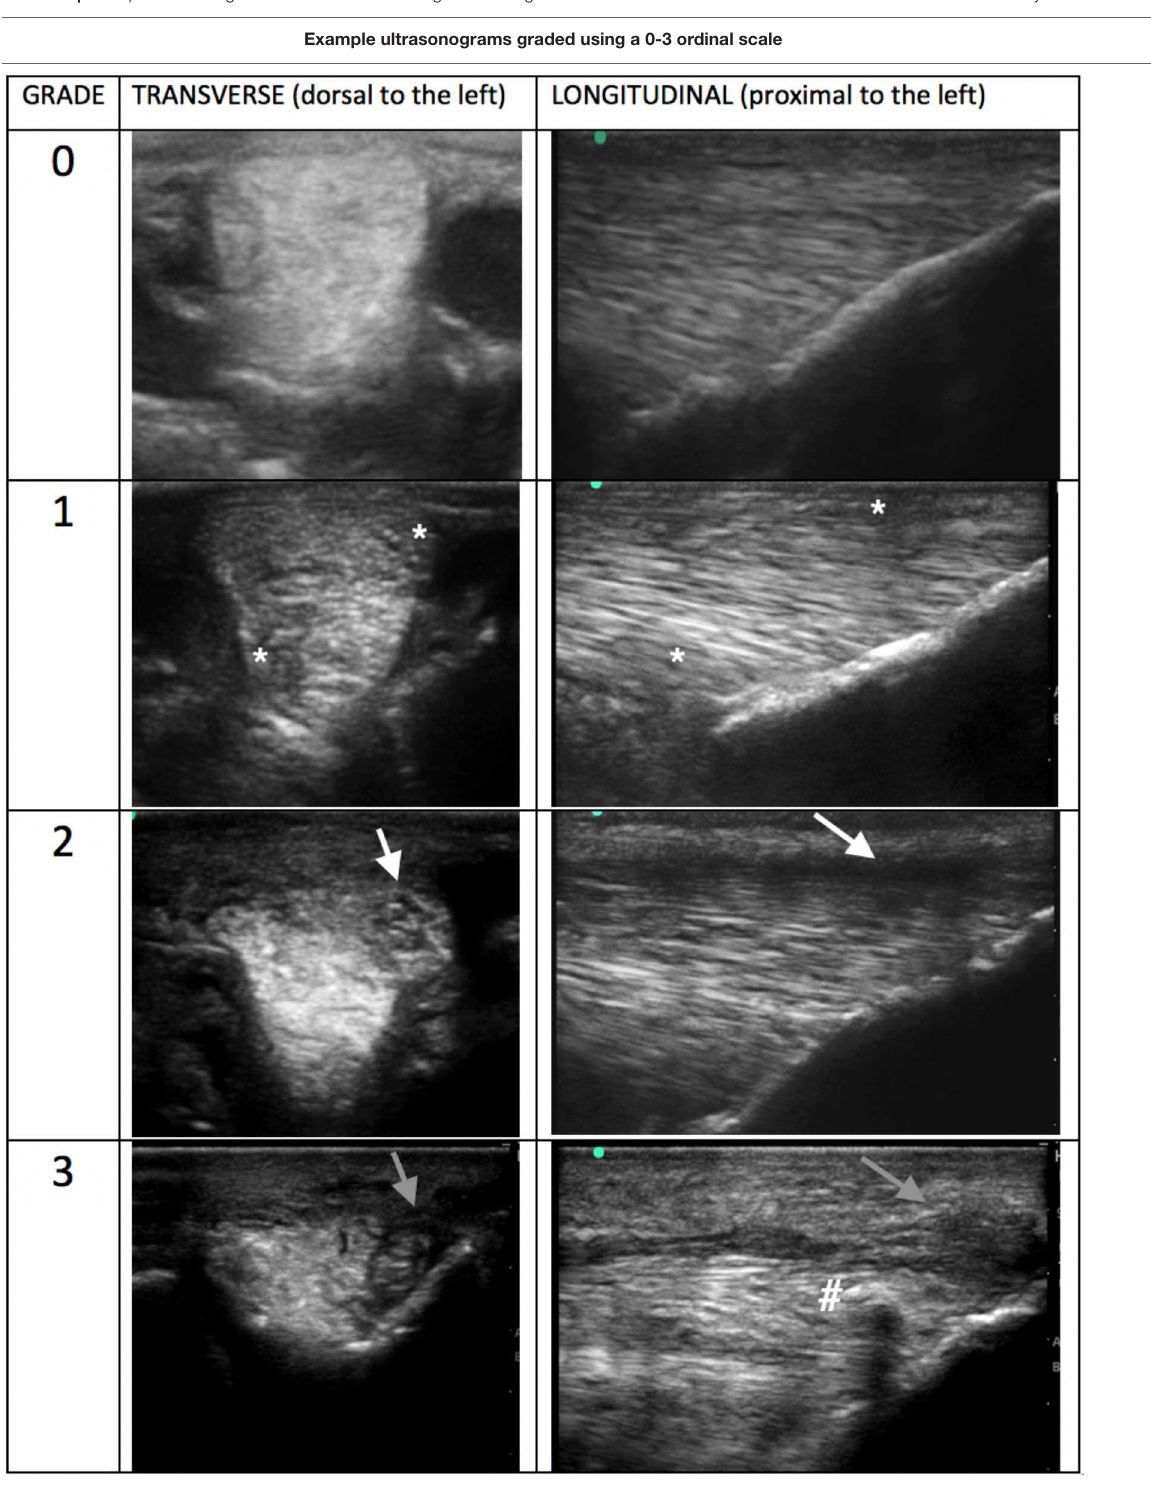
TABLE 2 | Example ultrasonograms in transverse and longitudinal for grade 0–3 branches taken of SLBs from horses included in this